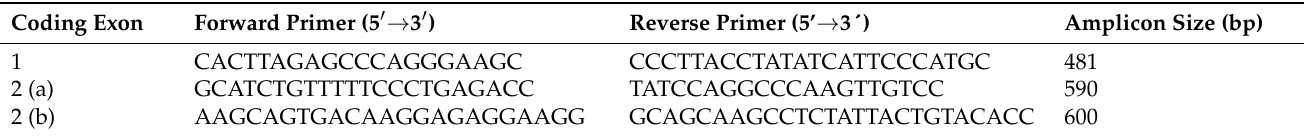
Table 3. Primer pairs to amplify the coding sequences and splicing sites of the BMP10 gene.